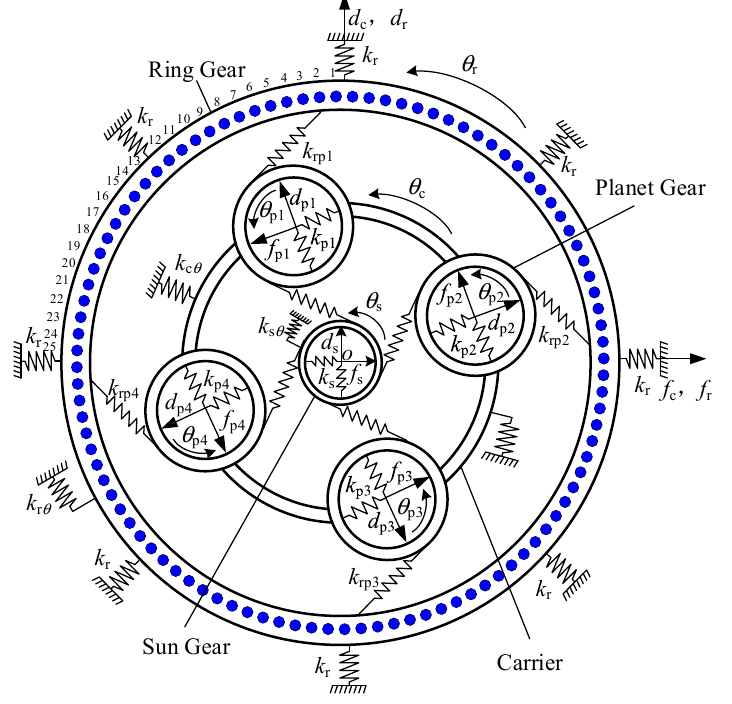
Figure 2. System dynamics model.